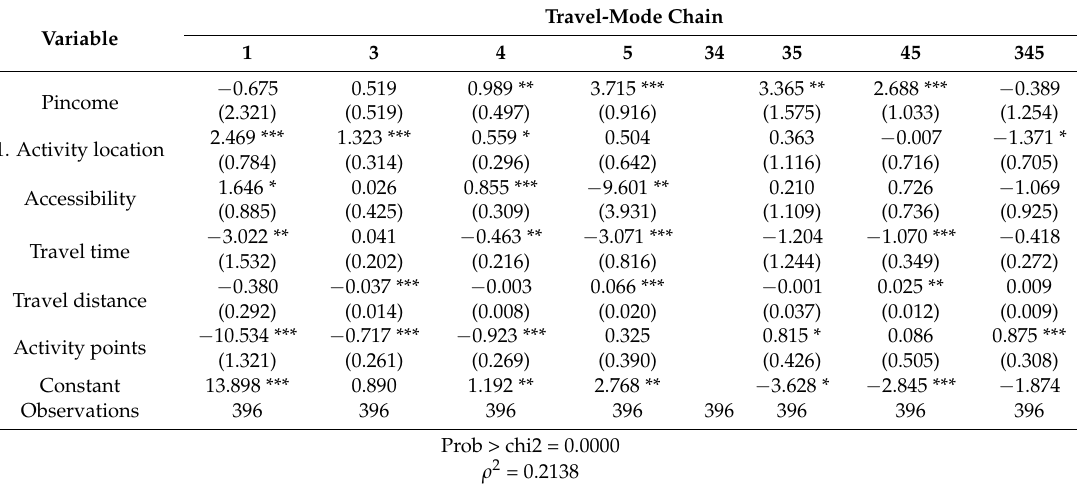
Table 9. Parameter estimates and their significance.